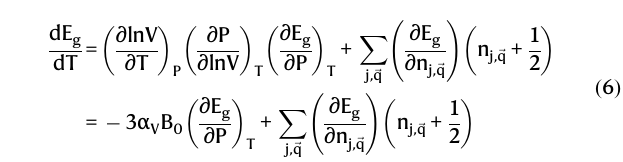
Fig. 5 | Temperature dependent optical characteristics of Cs x FA 1-x PbI 3 PQDs. a In situ PLspectraforFAPbI 3 , Cs 0.25 FA 0.75 PbI 3 ,Cs 0.5 FA 0.5 PbI 3 , Cs 0.75 FA 0.25 PbI 3 ,and CsPbI 3 PQDs. b FWHMextractedfrominsituPLspectra.Thedataarenormalizedto the maximum intensity. The black squares are the experimental data fi tted using Segall ’ sexpression(redsolidline).ThePLexcitonlinewidthbroadeningarisesfrom inhomogeneousbroadeningterm Γ ( T )= Γ 0 (orangedash-dotline),acousticphonon